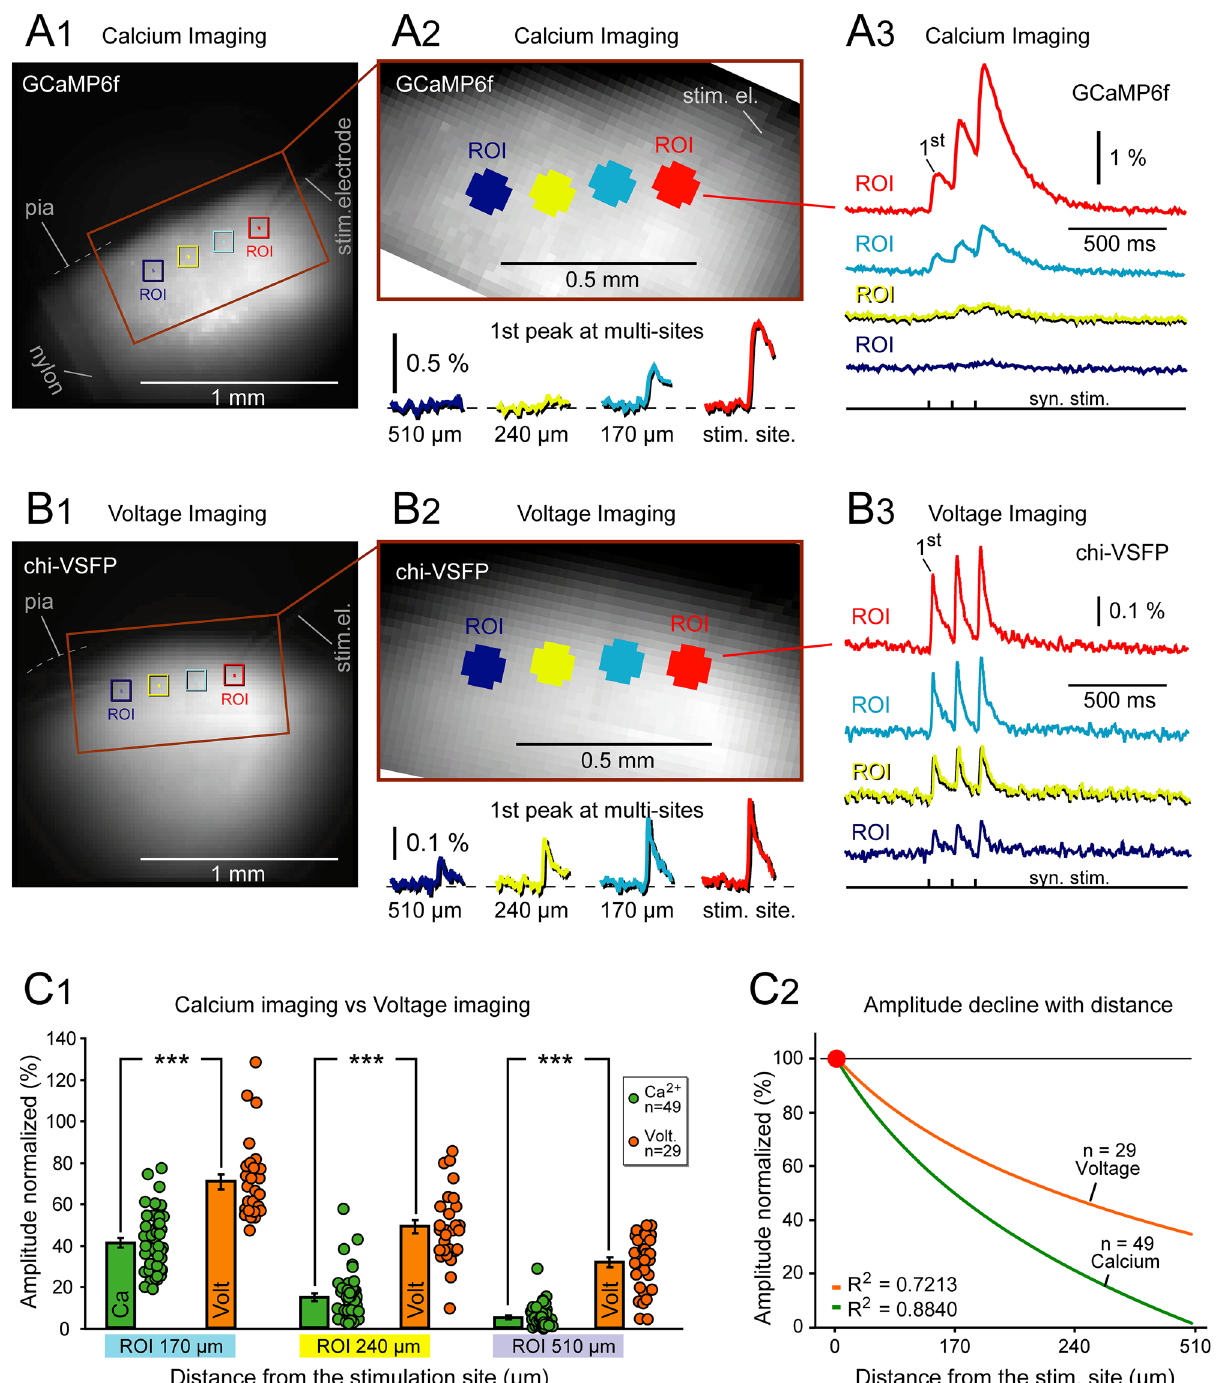
Figure 5. Attenuation of optical signals with distance from the stimulation site—calcium vs. voltage imaging. ( A ) A brain slice from transgenic animal expressing GCaMP6f in cortical pyramidal neurons. Synaptic stimulation electrode (el.) is positioned in cortical layer 2/3. ( B ) Blowup of the area marked by rectangle in ( A ). ( C ) Calcium signals recorded simultaneously from four ROIs marked by color in ( B ). Each trace is a spatial average of 21 pixels and temporal average of 4 trials. The first signal peak (response to the first synaptic pulse) is displayed on a greater scale below the image in ( B) . Signals at 170, 240 and 510 µm, from the stimulation site, are shown on identical amplitude and time scales. DEF Same as ABC , except the transgenic animal expresses chi-VSFP in cortical pyramidal neurons. ( G 1 ) Signal amplitudes (response to first synaptic pulse) were normalized against the amplitude obtained at the stimulation site (red ROI). Each dot represents one recording. Calcium: n = 27 traces, 5 slices, 3 animals. Voltage data: n = 29 traces, 9 slices, 6 animals. Bars represent mean ± SD. ***, p < 0.0001. ( G 2 ) Data points shown in G1 were fitted with logarithmic function and the trends are displayed. Distance “0 µm” is at the stimulation site (red